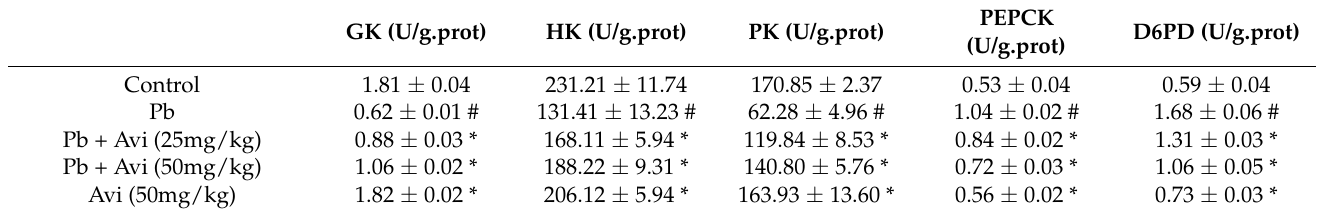
Table 2. Effect of avicularin on the activities of those glucose metabolism enzymes in the liver. GK (U/g.prot)